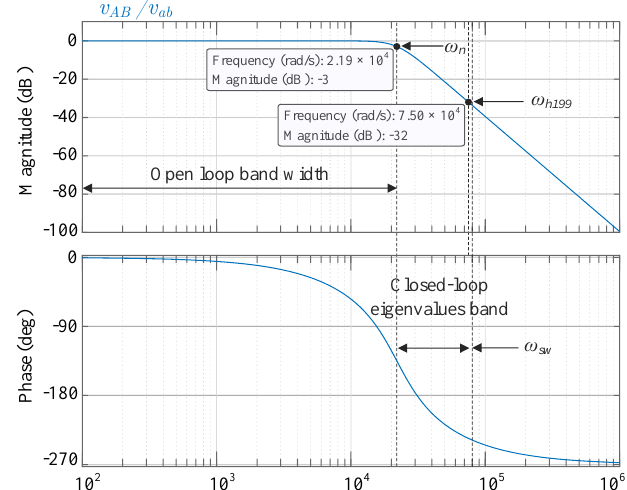
Figure 3. G ( s ) Bode diagram in islanded